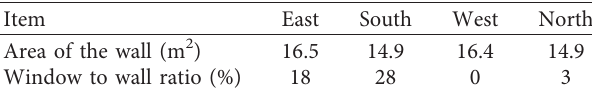
Table 6: Structural parameters of the tested room.